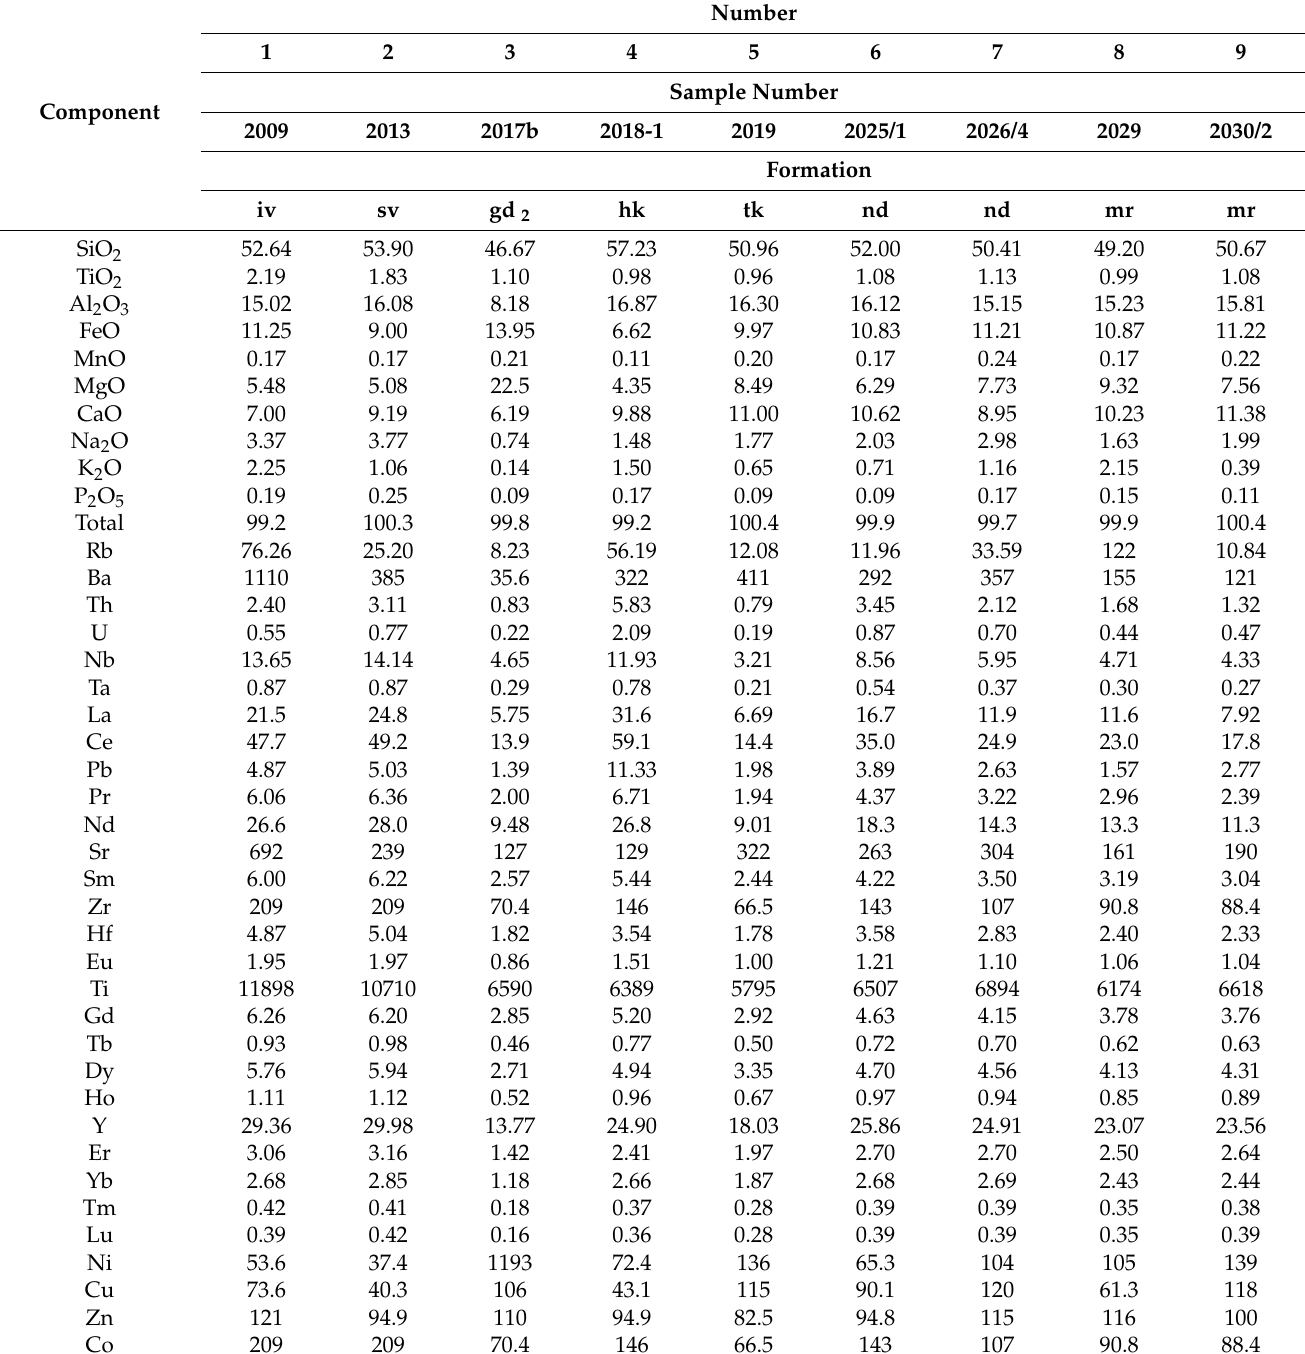
Table 3. Representative volcanic rock compositions in the Khikey River